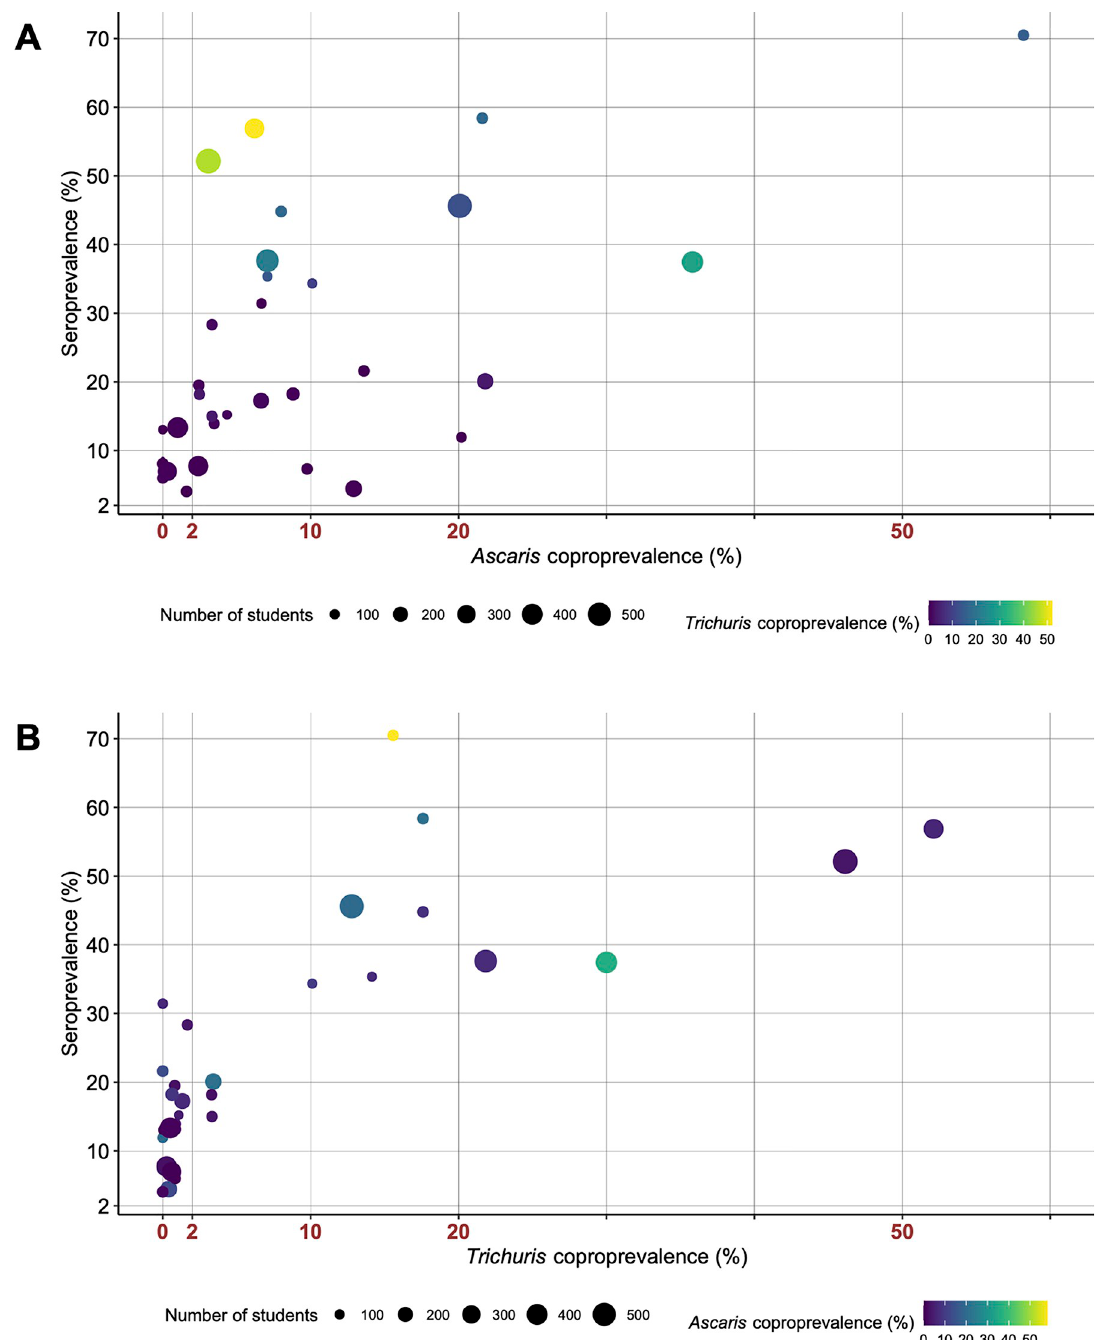
Fig 3. Correlation between coproprevalence and seroprevalence on woreda level. Panel A shows the correlation between Ascaris coproprevalence and seroprevalence, including Trichuris prevalence of the woredas as indicated by their color. Panel B displays the correlation between Trichuris coproprevalence and seroprevalence, showing Ascaris coproprevalence by color scale. The WHO coproprevalence thresholds for program decision-making regarding the frequency of drug administration are indicated in red on the x- axis [15]. The size of the dots indicates the number of screened students per woreda.